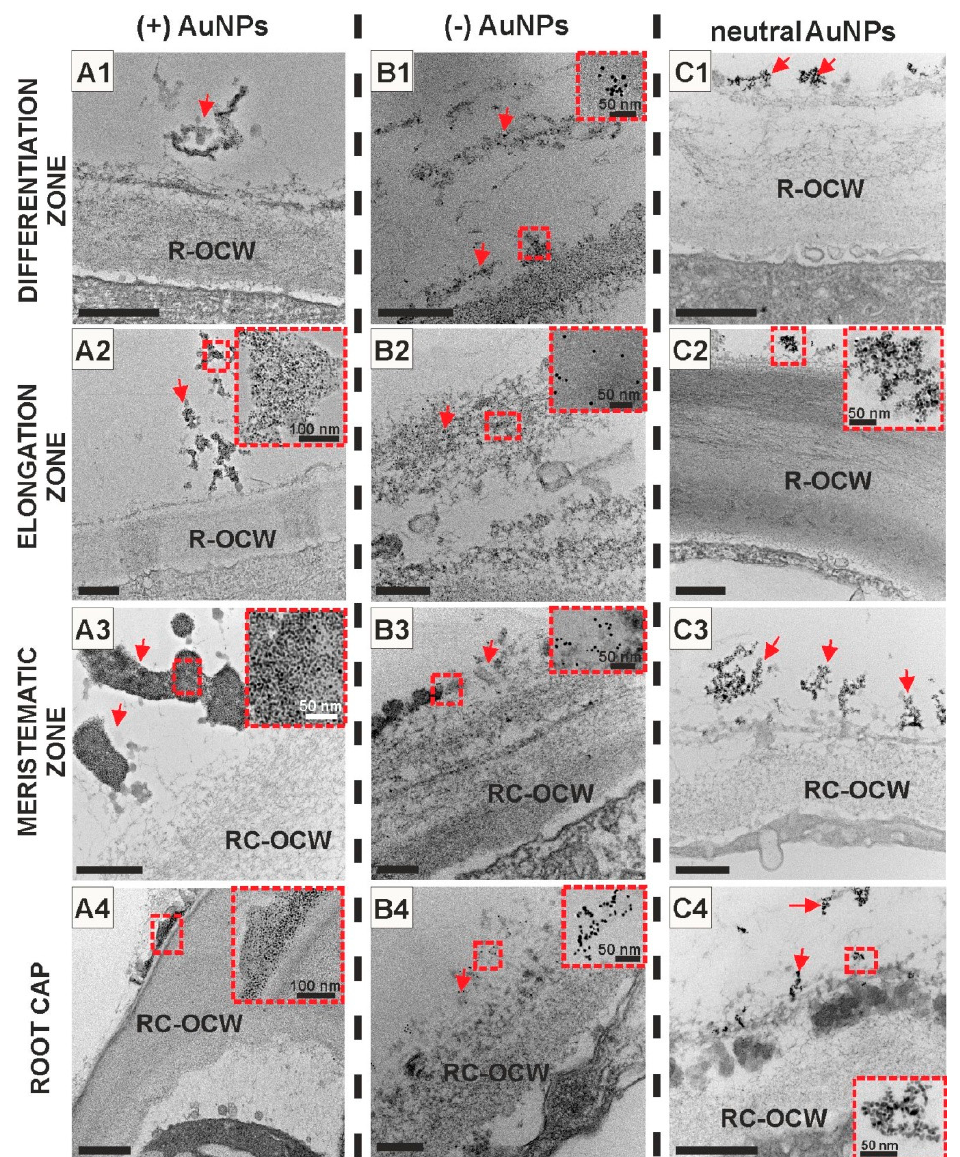
Figure 5. Ultrastructure of Arabidopis thaliana root surface along all of root zones. AuNPs regardless of their surface charge: (+) AuNPs ( A1–A4 ), (-) AuNPs ( B1–B4 ) and neutral AuNPs ( C1–C4 ) did not pass the cell wall and they were retained on the root surface; red arrows indicate AuNPs, insets—high resolution images of AuNPs. R-OCW—root outer cell wall, RC-OCW—root cap outer cell wall. Scale bars: A1–A4 , C1–C4 = 500 nm; B1–B4 = 200 nm.